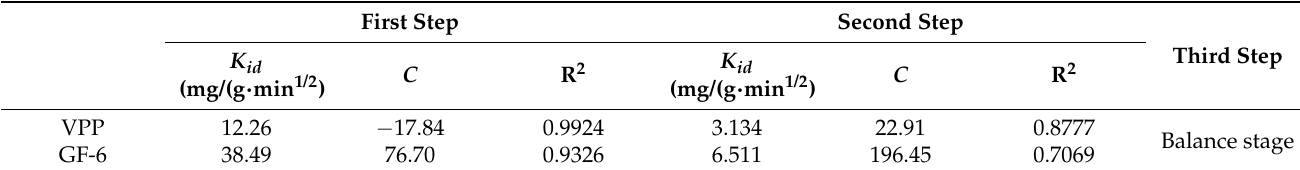
Table 2. IPD kinetic parameters for VPP and GF-6 adsorption on AmZPP 5000